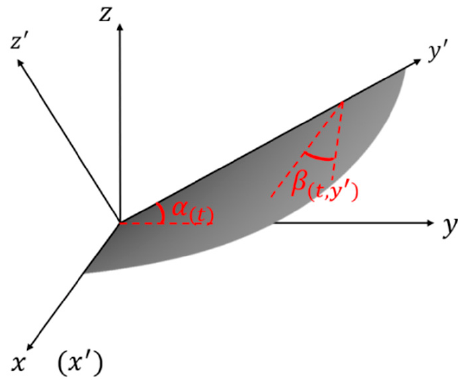
Figure 5. Flexible deformation of wing.